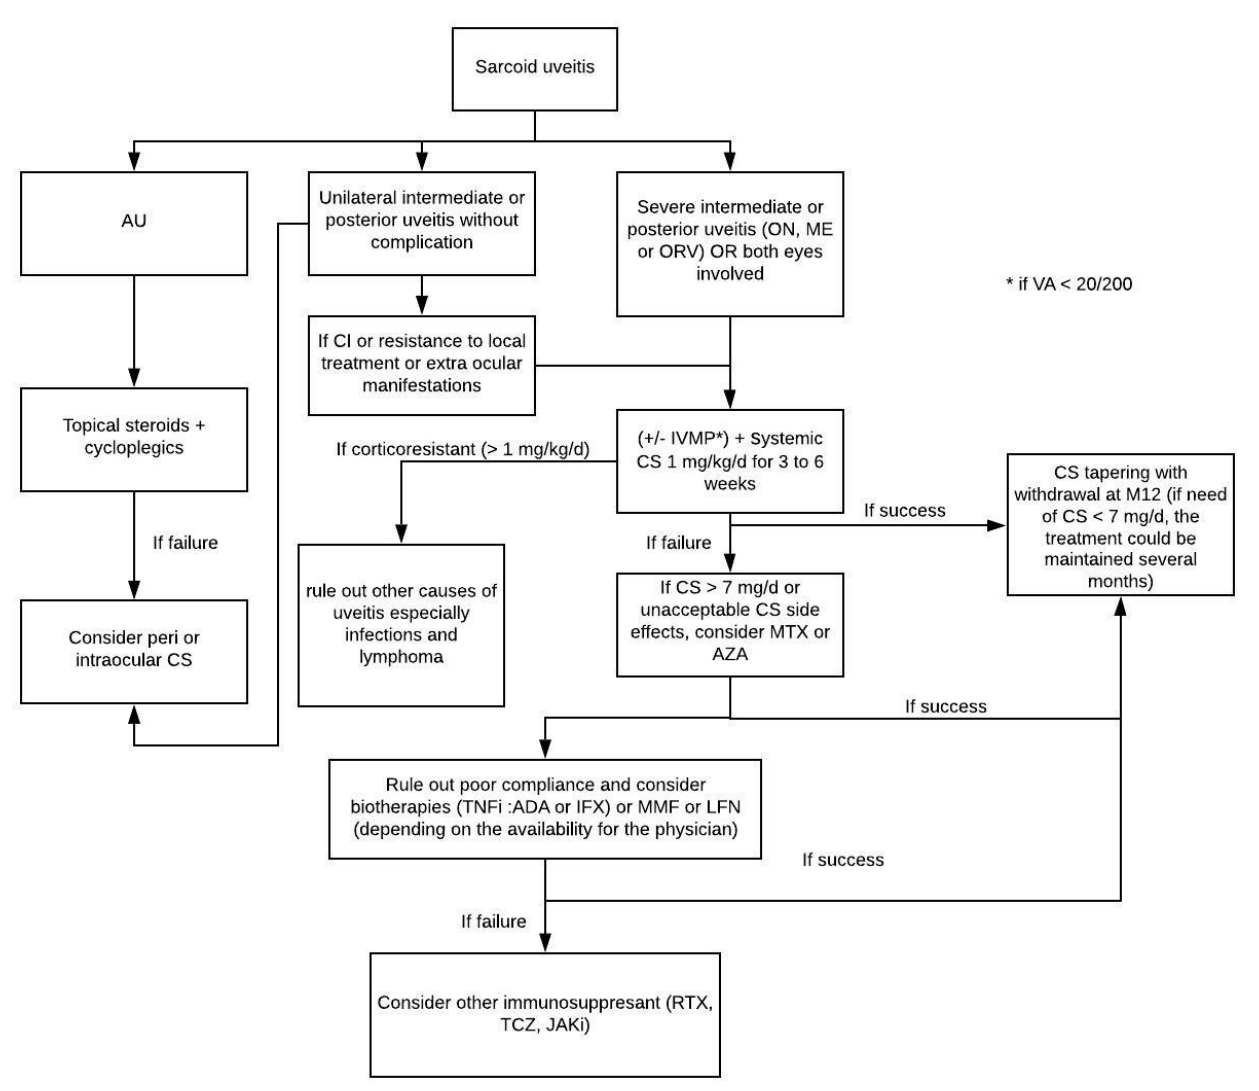
Figure 9. Corticosteroids management in non-infectious uveitis (Sève et al., Sem Resp Crit Care Med , 2020). Abbreviations: AU: anterior uveitis; CS: corticosteroids; ON: optic neuritis; ME: macular edema; ORV: occlusive retinal vasculitis; VA: visual acuity; IVMP: intravenous methylprednisolone pulse; CI: contra indication; TNFi: Tumor Necrosis Factor inhibitor; ADA: adalimumab; IFX: infliximab; MTX: methotrexate; AZA: azathioprine; MMF: mycophenolate mofetil; LFN: leflunomide; RTX: rituximab; TCZ: tocilizumab; JAKi: Janus kinase inhibitor.